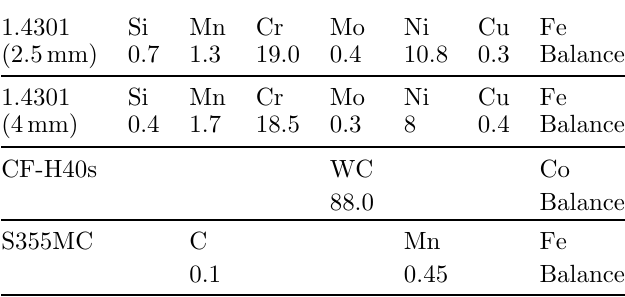
Table 1. Chemical composition (elements over 0.1%) of the materials used in weight